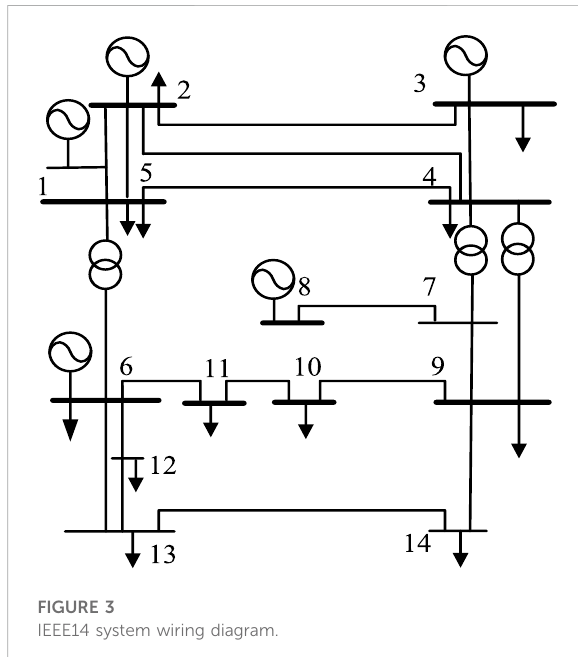
FIGURE 3 IEEE14 system wiring